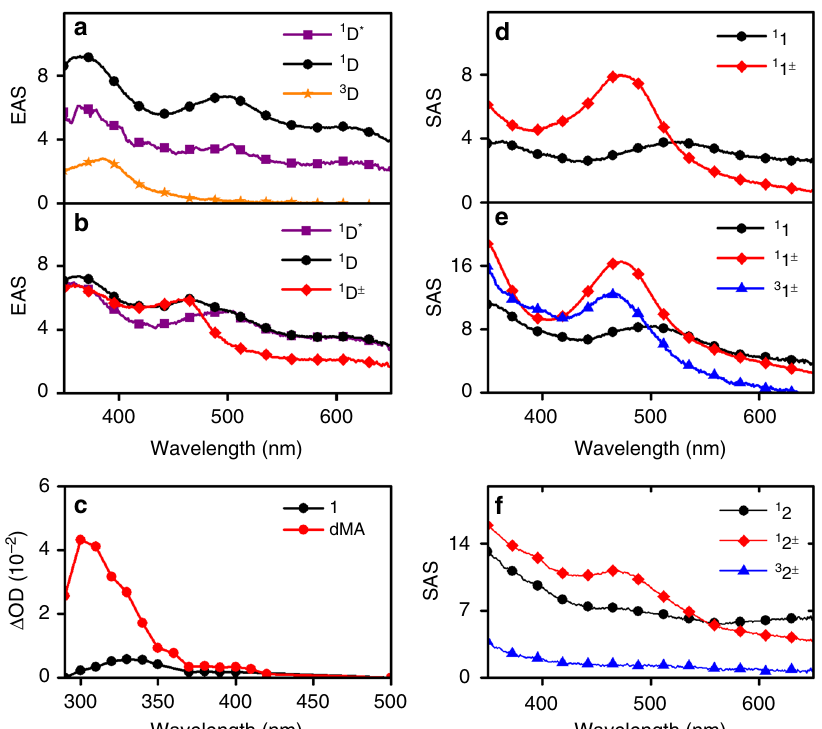
Fig. 4 Transient absorption. Evolution-Associated Spectra (EAS) of dMA in the absence ( a ) or presence ( b ) of 0.1 M iPN in isopropyl ether. Flash photolysis of dMA and 1 ( c ) in n-butyl ether illustrating triplet-triplet absorption 100 ns after excitation. Species-Associated Spectra (SAS) of 1 in dichloromethane ( d ) and isopropyl ether ( e ) and of 2 in chloroform ( f